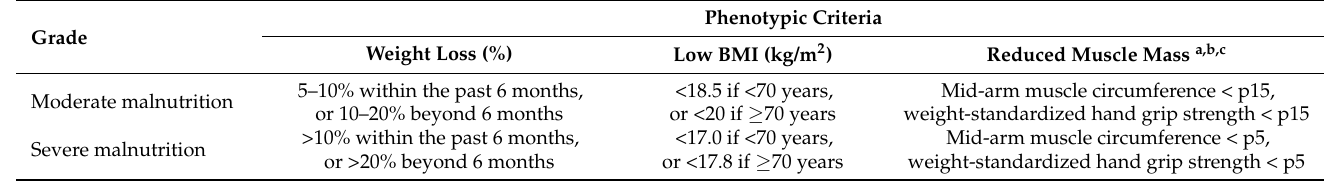
Table 3. Parameters and Thresholds Used for GLIM Severity Grading in the Present Study.